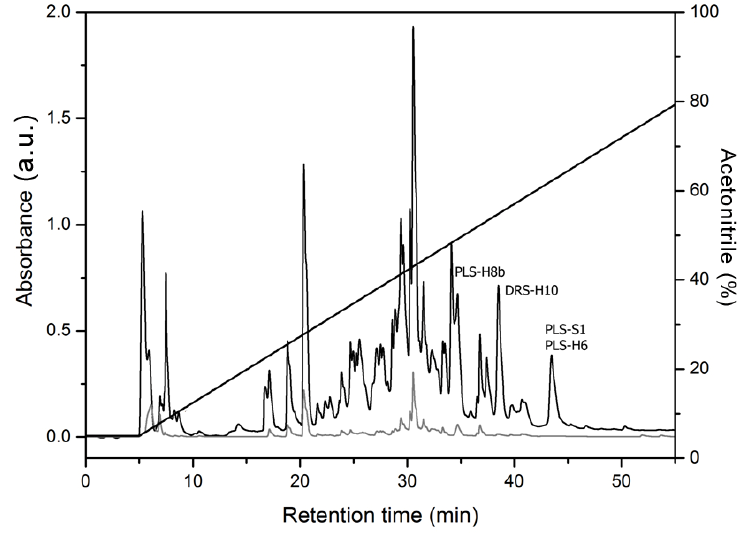
Figure 1. Fractionation of the lyophilized crude extract of the total skin secretion from P. nordestina . The elution of the peptides was performed using a linear gradient of H and acetonitrile supplemented with 0.1% (v/v) trifluoroacetic acid at a 2.5 mL/min flow rate. The absorbance was monitored simultaneously at two wavelengths, 216 nm (black line) and 280 nm (grey line).